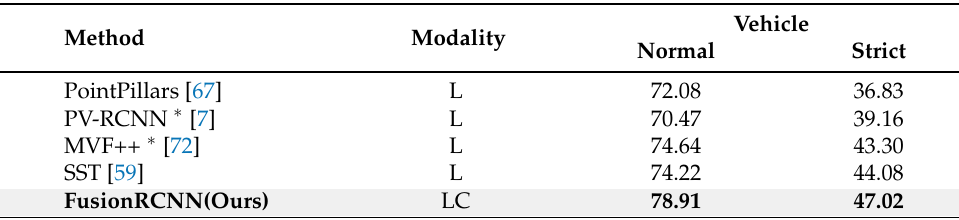
Table 3. Results on normal and strict IoU threshold. The normal and strict thresholds for vehicles are 0.7 and 0.8 on the Waymo validation set, respectively, ∗ : results from [72]. The top results are bolded in the table. Method